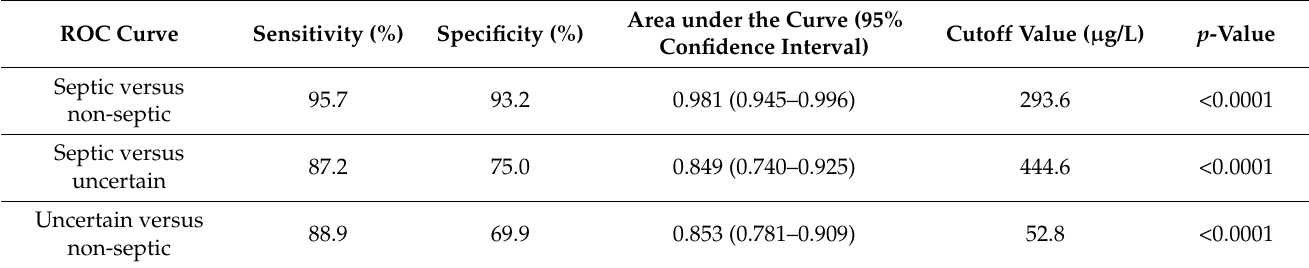
Table 2. Discriminatory ability of neutrophil gelatinase-associated lipocalin in synovial fluid for identification of three groups of horses: septic synovitis ( n = 47 samples), non-septic ( n = 103 samples), and uncertain status ( n = 27